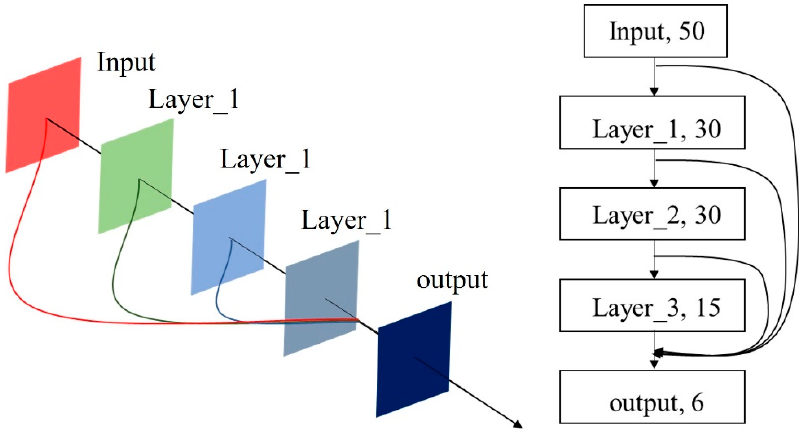
Figure 3. Schematic diagram of the generator structure.